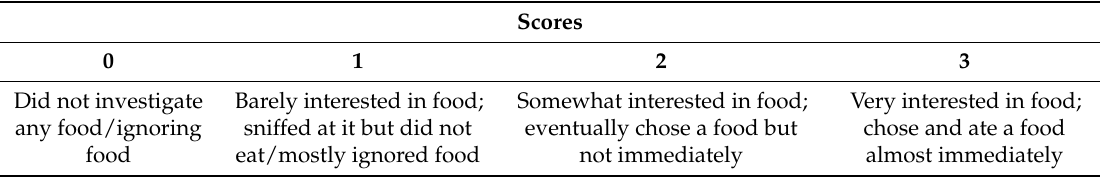
Table 2. Scoring system for interest in food upon presentation during